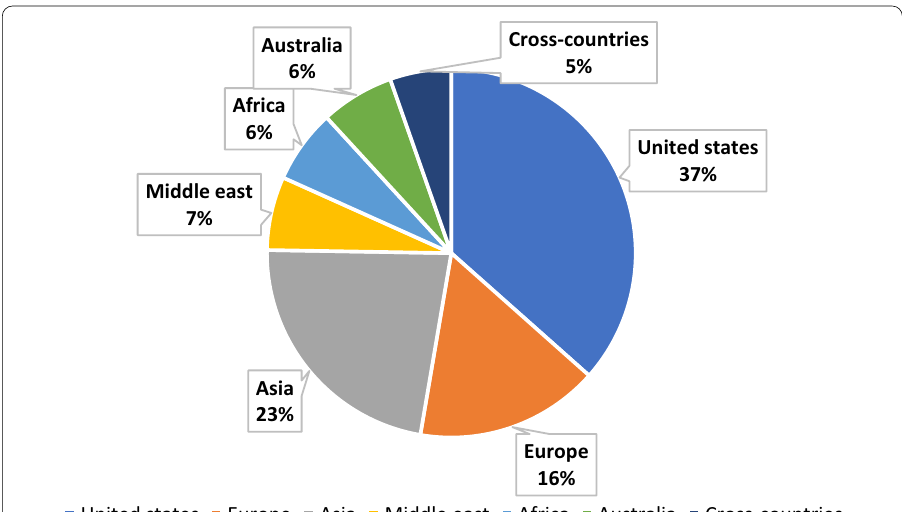
Fig. 4 Distribution of published studies by